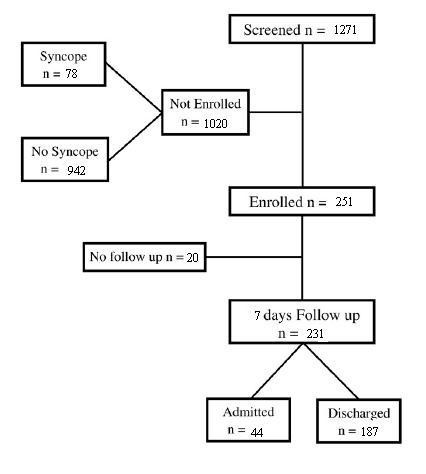
Study population.